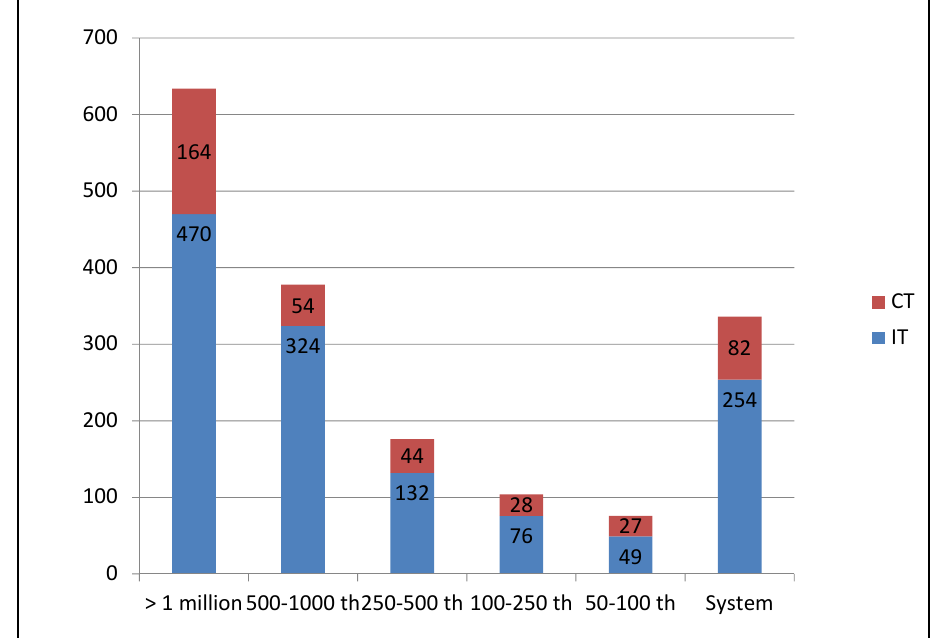
Figure 7. Energy consumed per inhabitant per day by transport type (Petroleum Equivalent Grams). Source: MMA